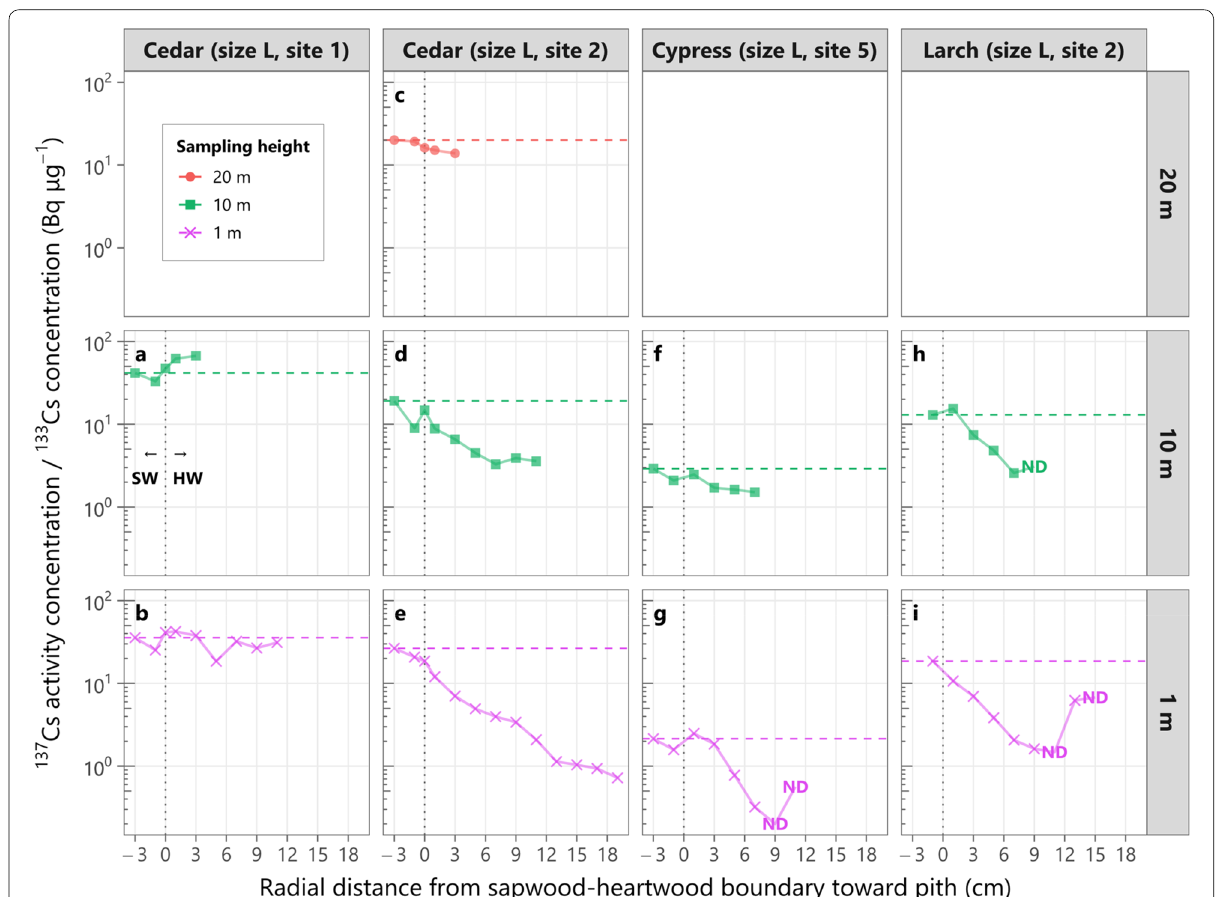
Fig. 4 Radial distribution of the 137 Cs/ 133 Cs ratio in wood sampled at different vertical positions in 2014. a – e Japanese cedar ( Cryptomeria japonica ); f , g Japanese cypress ( Chamaecyparis obtusa ); h , i Japanese larch ( Larix kaempferi ). ND letters indicate that 137 Cs activity in the samples was under the detection limit and show the detection limit values. SW sapwood, HW